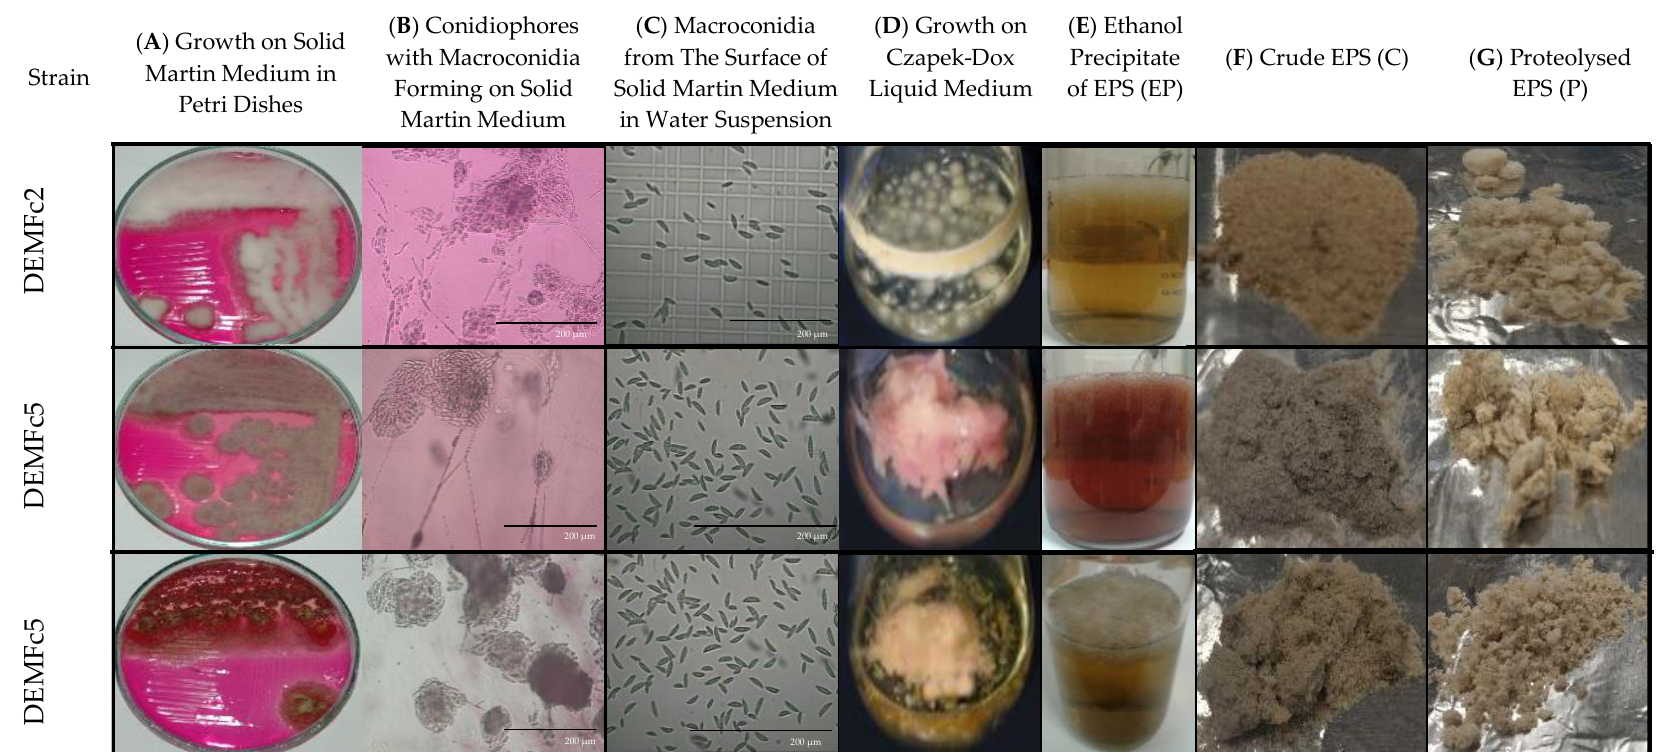
Figure 2. Macrographs ( A , D , F , G ) and LM micrographs ( B , C ) documenting the steps of the procedure of obtaining three forms of EPS from three Fusarium culmorum strain cultures.